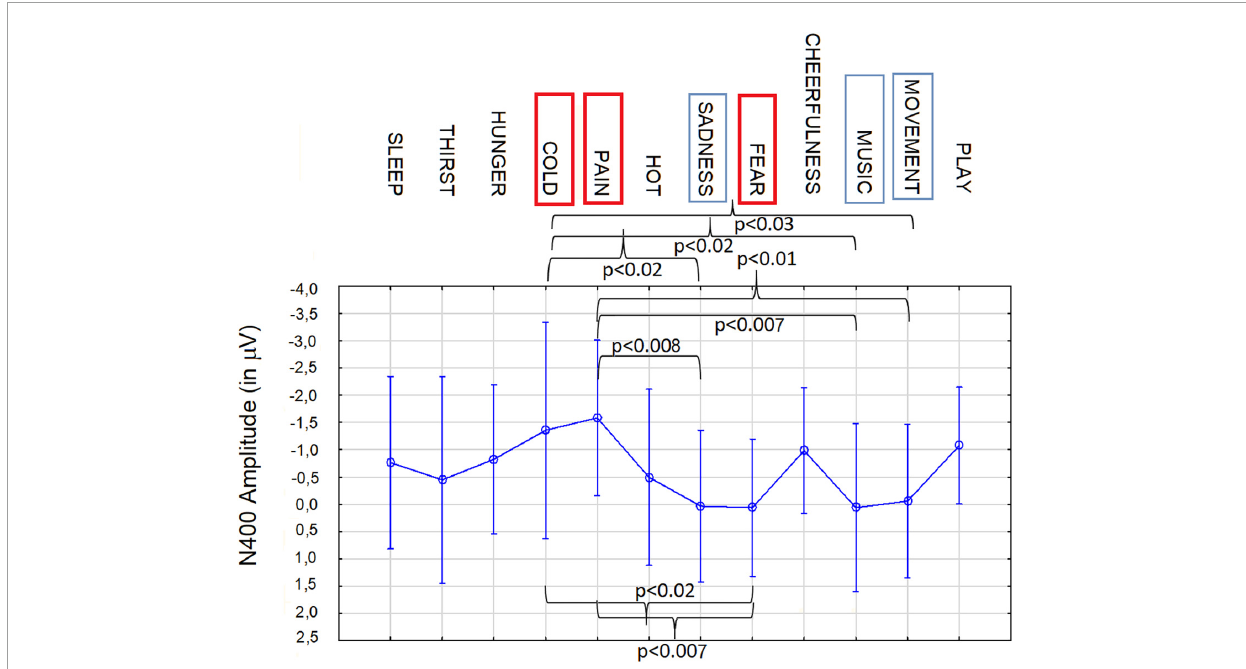
FIGURE9 Mean area amplitude values of N400 responses recorded at AF3 and AF4 sites in the 400–600 ms time window, during imagination, as a function of the need category. Anterior N400 appears to be a reliable neuroelectric marker, in showing significant differences in magnitude depending on the valence and the sensory, emotional, or visceral nature of the motivational/physiological imaginal